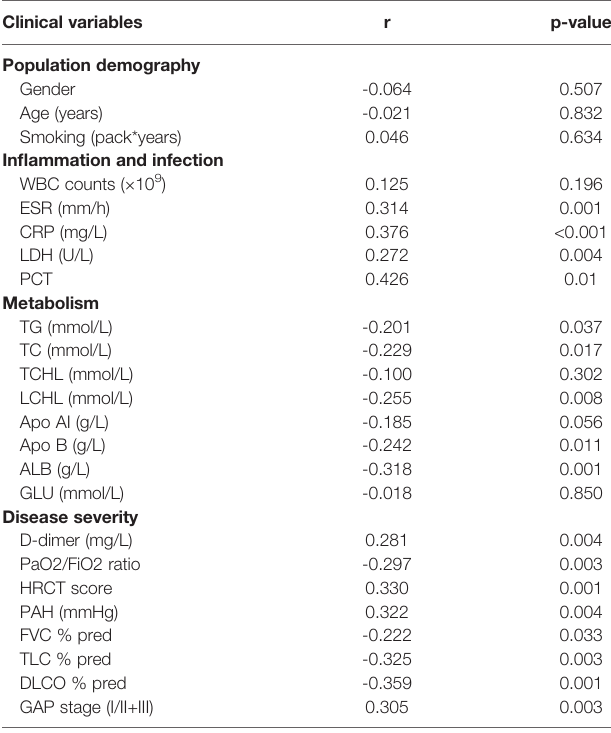
TABLE 2 | Bivariate correlation analysis between serum GDF-15 and clinical variables in IPF patients. Clinical variables r